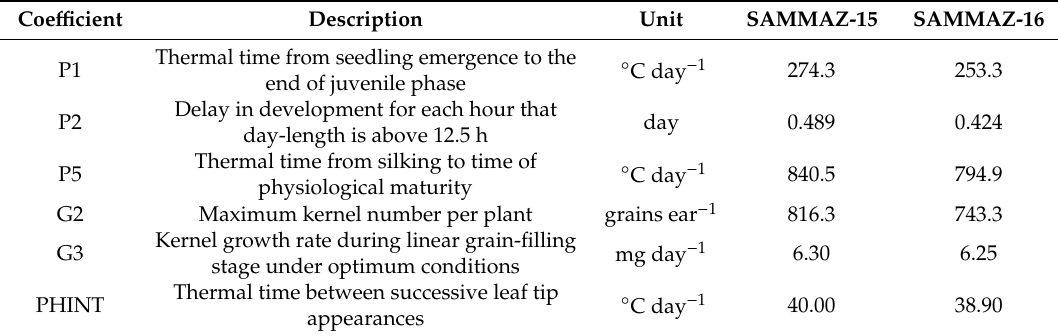
Table 2. Genetic coefficients of maize varieties used in the study. To assess the accuracy of the cultivar coefficients derived from model calibration, simulated values for days to anthesis, days to physiological maturity, grain yield, and shoot dry matter at harvest for SAMMAZ-15 and SAMMAZ-16 varieties were compared with the corresponding observed values (Table 3). A close agreement was found between simulated and observed values for all four measured parameters. The model slightly under estimated all the parameters for both varieties except grain yield for SAMMAZ-15 and shoot dry matter for both varieties, although they are within acceptable range according to the evaluation statistics (Table 4). The statistical values of simulated and measured days to anthesis and physiological maturity ranged from −0.002 to −0.02 days for mean error, 1.9 to 2.3 days for RMSE and 0.93 to 0.97 for d-index for both varieties. The comparison between simulated and observed grain yields were also quite good for both maize varieties. The RMSE values for grain yield was 470 kg ha −1 for SAMMAZ-15 and 245 kg ha −1 for SAMMAZ-16 while d-index values were above 0.90 for both varieties. The predictions for shoot dry matter were also good for both varieties; the RMSE values for shoot dry matter was 1728 kg ha −1 for SAMMAZ-15 and 1152 kg ha −1 for SAMMAZ-16 while d-index value was 0.75 and 0.80 for SAMMAZ- 15 and SAMMAZ-16, respectively. Table 3. Simulated and observed mean values for anthesis, physiological maturity, grain yield, and shoot dry matter at maturity with their respective statistical indices for the calibrated maize varieties. Parameter NE ƪ Simulated Observed ME ª RMSE d-Index